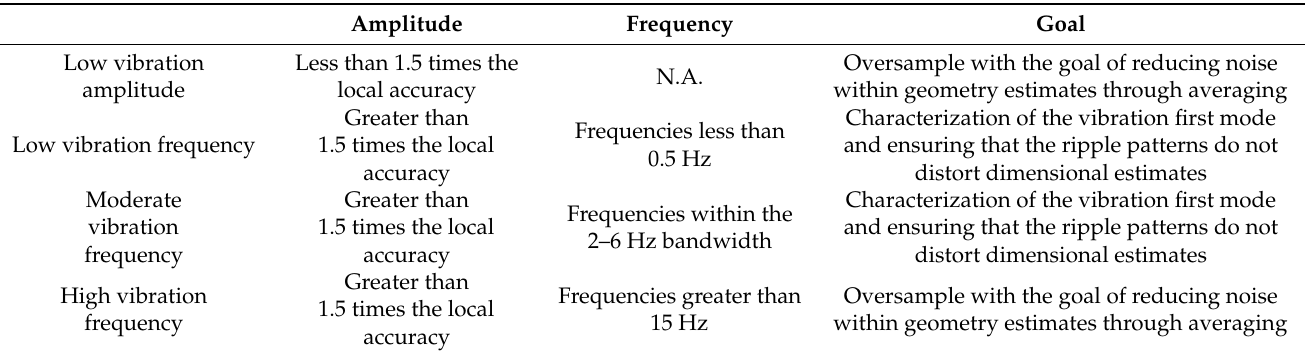
Table 11. Recommended LiDAR scanning goals based on the vibration frequency and amplitude being